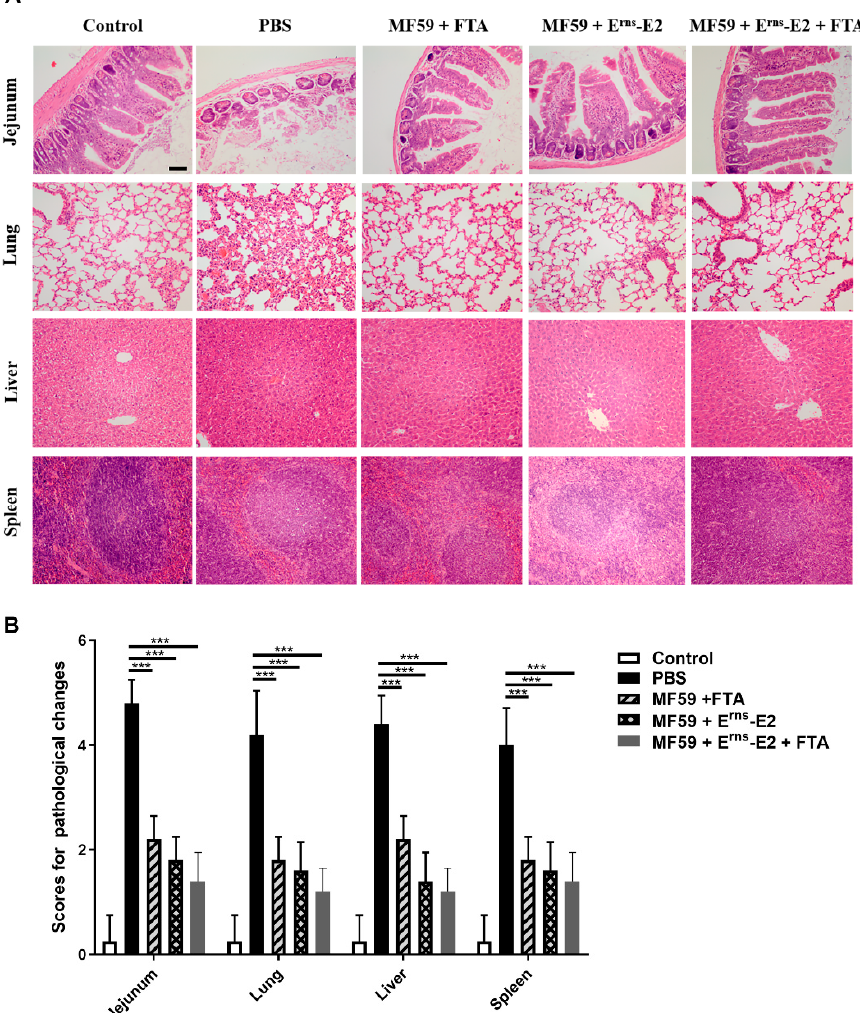
Figure 7. The histopathological changes and scores of pathological changes after challenge following the recombinant E rns -E2 protein vaccine-FTA adjuvant combination treatment. ( A ) Histopathological changes were observed in the lungs, spleen, and intestines of the mice from each group. Scale bars, 100 μ m. ( B ) Scores of pathological changes in tissues of mice. Pathological changes in tissues were evaluated by a veterinary pathologist and scored from 0 to 5 in a blinded study. Data from three independent experiments and error bars are presented as the mean ± SEM. *** p < 0.001.